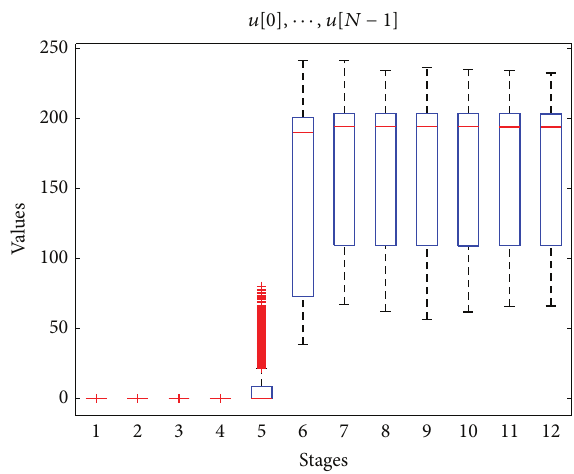
Figure 4: Case 1, box-plots for first product inventory levels when ordering by 70th percentile.